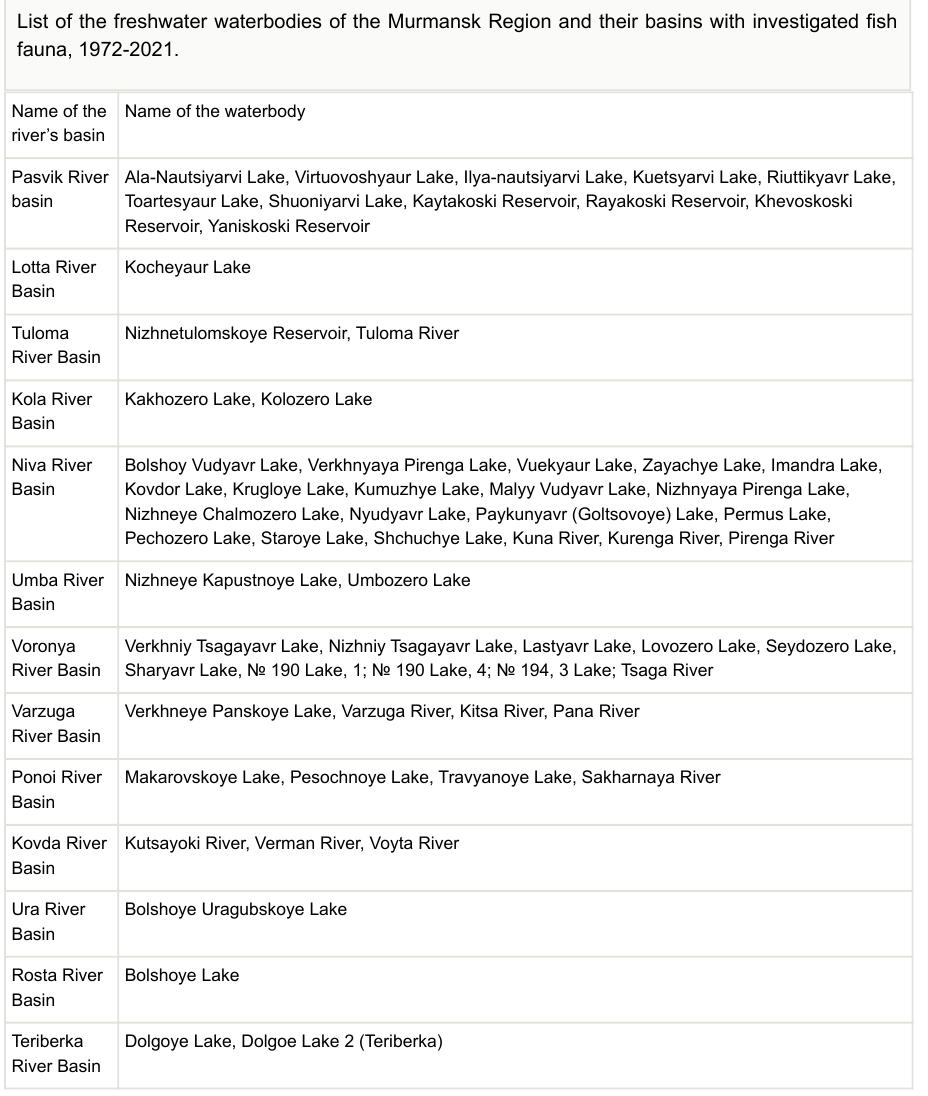
Description: This dataset contains information about distribution of the fish species of 67 freshwater waterbodies (15 river basins) of the Murmansk Region (Table 1).